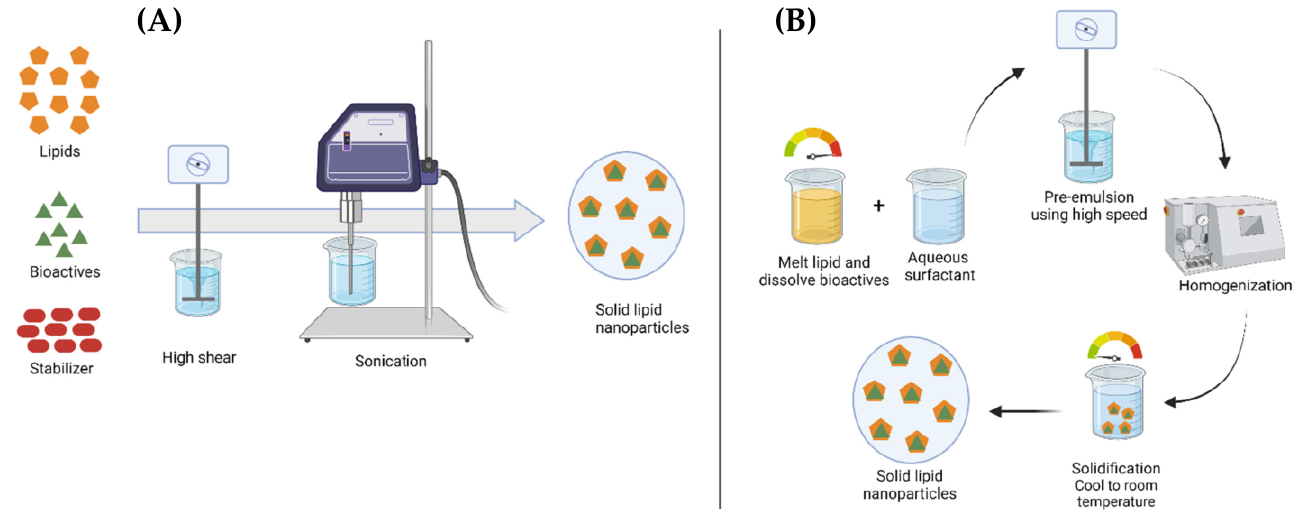
Figure 3. Schematic representation of ultrasonication method ( A ) and hot homogenization tech- Figure 3. Schematicrepresentationofultrasonicationmethod( A )andhothomogenizationtechnique( B nique ( B ) [80].